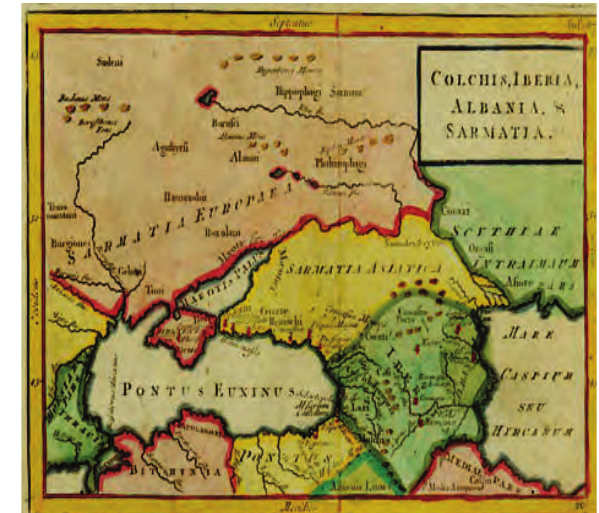
Fig. 9. Sarmatija in the map of Edward Wells, 1700